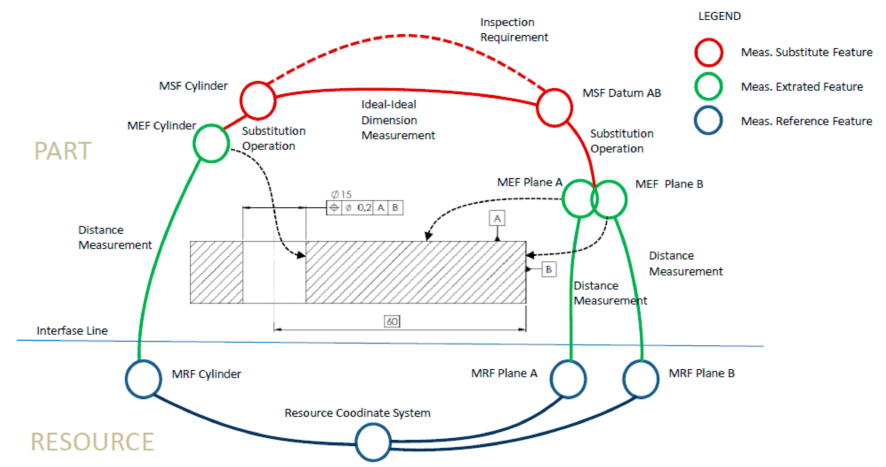
Figure 10. Graph including the InspF for the